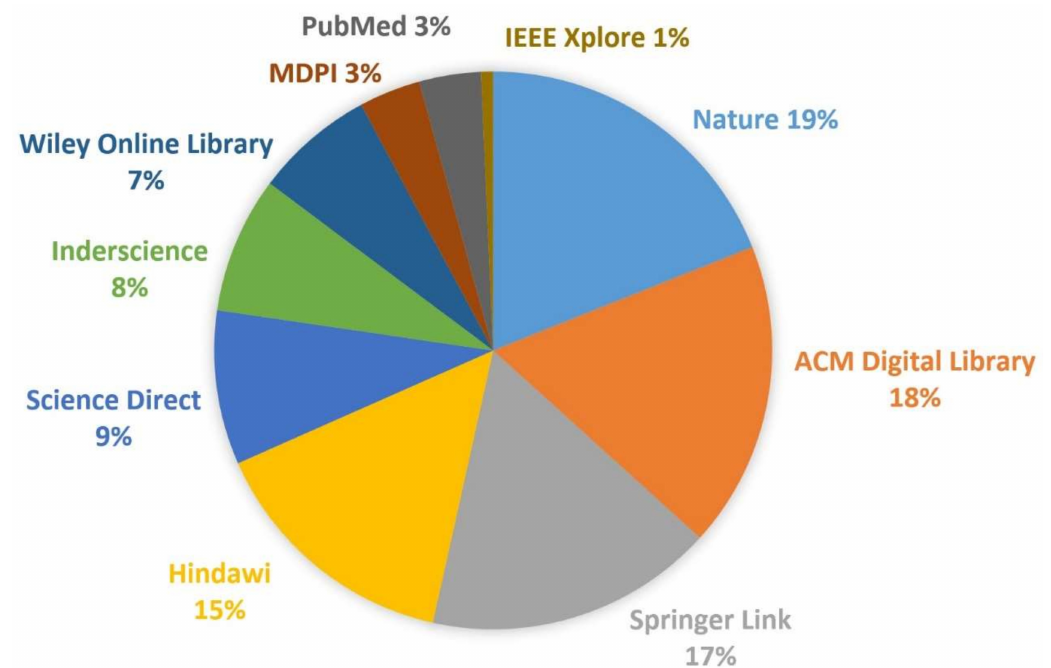
Figure 2. Distribution of Information